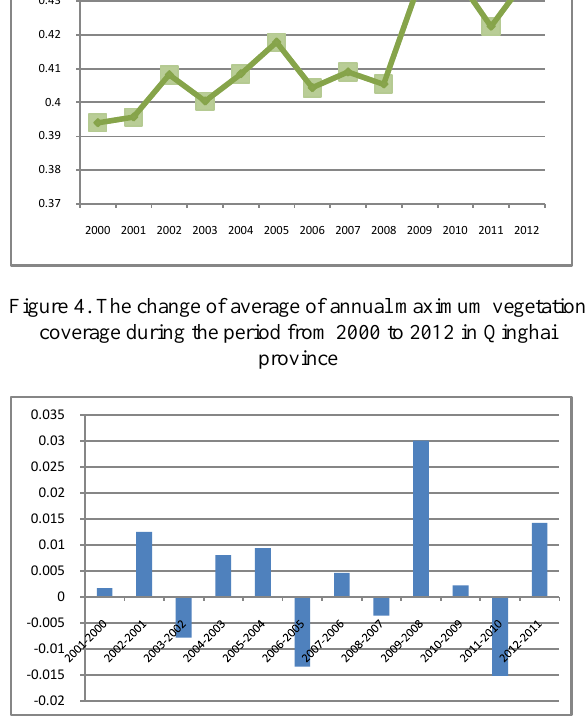
Figure 5. The change of average difference of annual maximum vegetation coverage during the period from 2000 to 2012 in Qinghai province